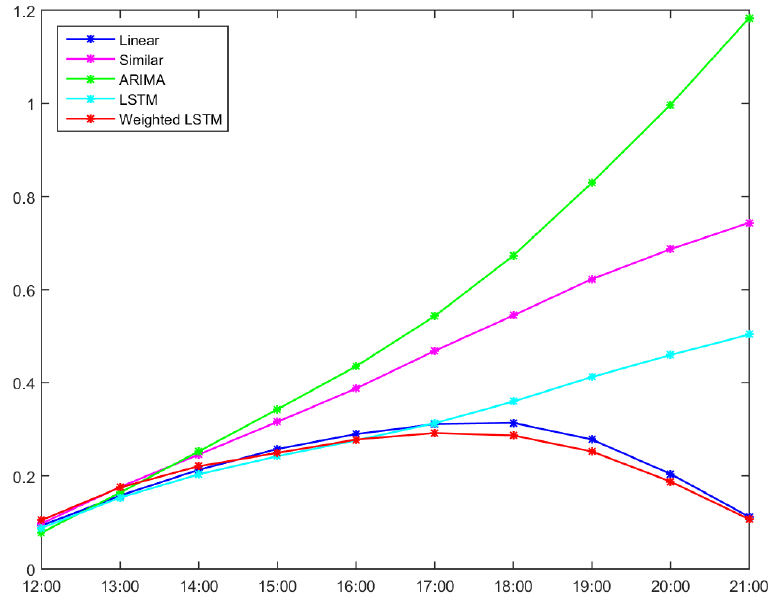
Figure 15. MAE of the five methods for all customers.